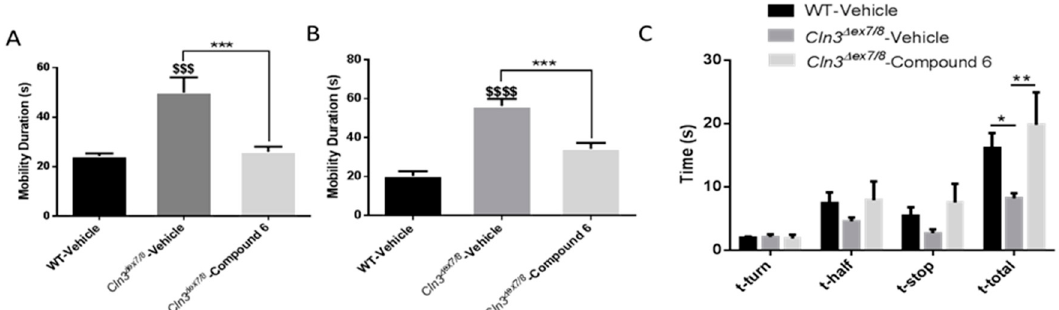
Figure 9. Impact of compound 6 treatment in Cln3 Δ ex7/8 mice. Open field behavioral parameter (mobility duration) in vehicle-treated WT, vehicle-treated Cln3 Δ ex7/8 , and compound 6-treated Cln3 Δ ex7/8 ( A ) male and ( B ) female mice ( n = 8 per group). Data are expressed as mean ± SEM. $ p : compared to WT vehicle-treated mice, and, * p : compared to vehicle-treated Cln3 Δ ex7/8 mice. *** p < 0.001, $$$ p < 0.001, and $$$$ p < 0.0001. ( C ) Pole climbing test in vehicle-treated WT, vehicle-treated Cln3 Δ ex7/8 , and flupirtine-treated Cln3 Δ ex7/8 male mice ( n = 8 per group). Time to turn (t turn ), time needed to reach center of pole (t 1/2 ), amount of time stopped (t stop ), and total time to descend (t total ) were recorded. Data are expressed as mean ± SEM. * p < 0.05, ** p < 0.01.